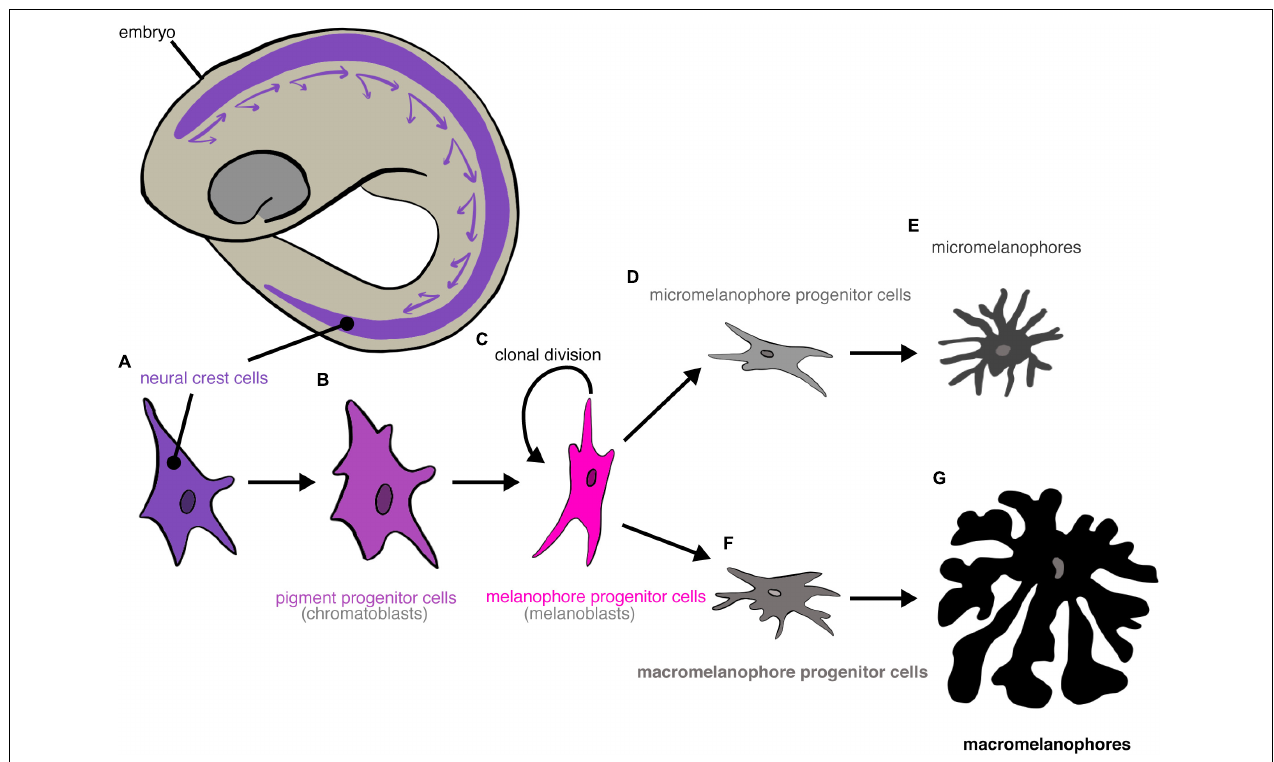
FIGURE 3 | Differentiation of poeciliid melanophore cells. Neural crest cells (A) migrate in a ventral-posterior direction. They differentiate into pigment progenitor cells (B) that then further differentiate into melanophore progenitor cells (C) . Melanophore progenitor cells either divide clonally or terminally differentiate into micromelanophore (D) or macromelanophore progenitor cells (F) , which differentiate terminally into micromelanophores (E) or macromelanophores (G) ,